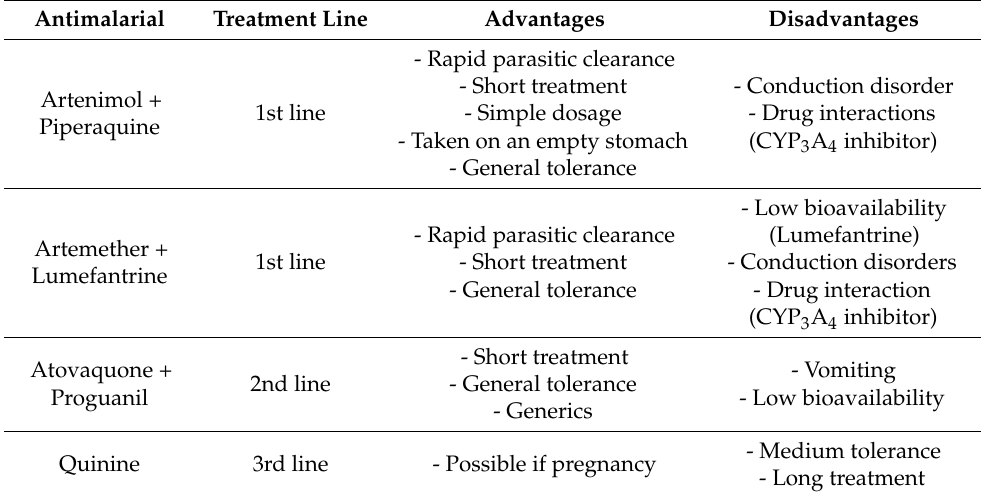
Table 2. Main antimalarial drugs for the treatment of malaria in adults